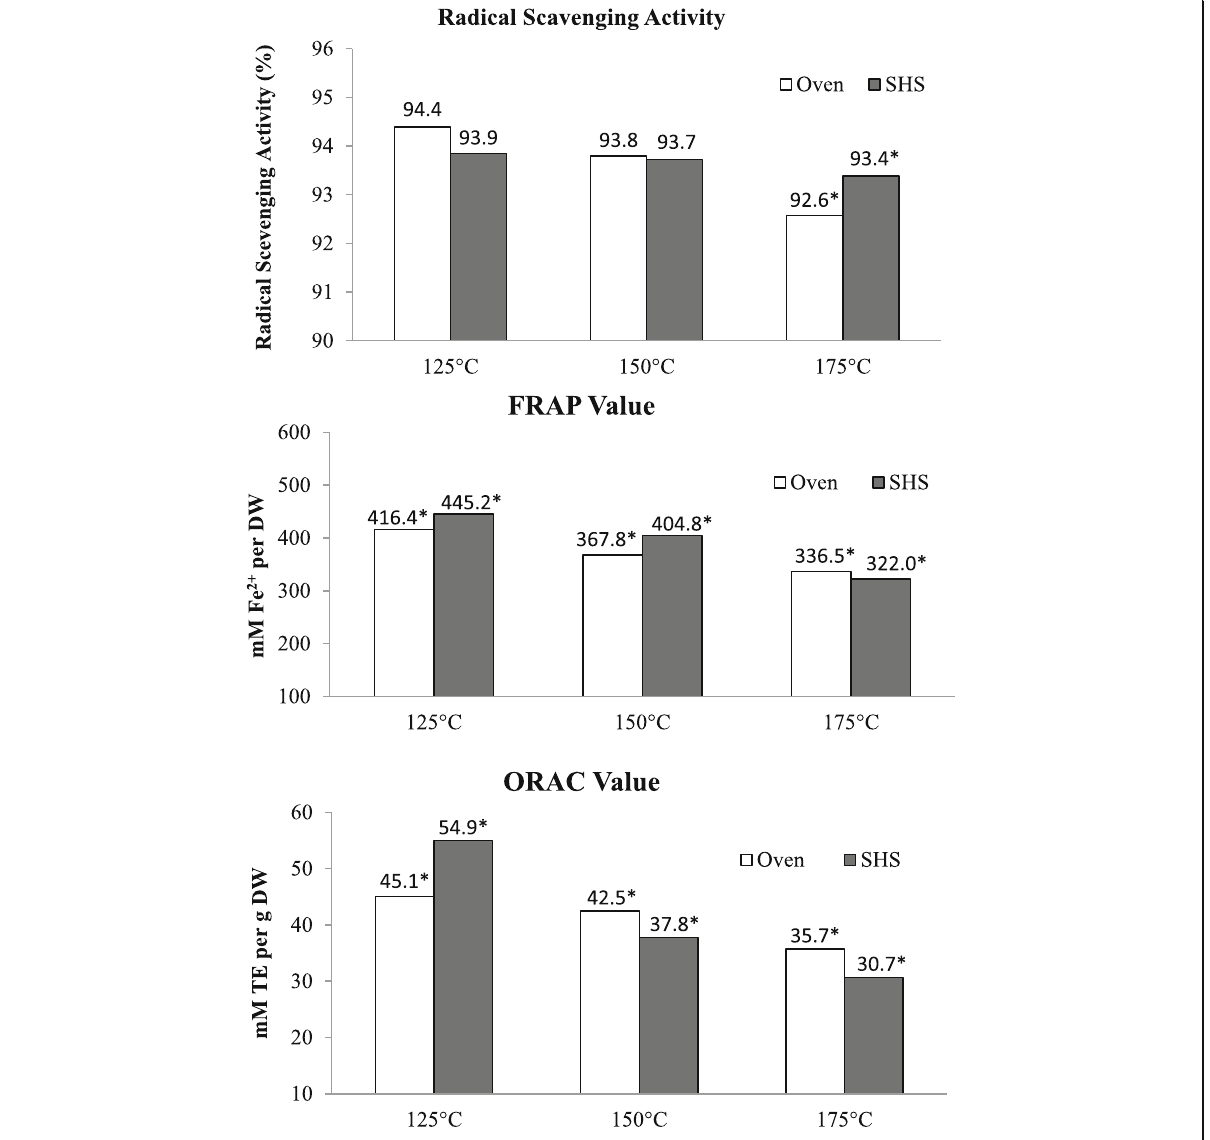
Fig. 2 Comparison of antioxidant capacity between oven dried and SHS dried tea leaves at different temperatures. (*) indicates significant differences ( p < 0.05) between values at the same temperature based on independent sample t-test. (SHS = Superheated